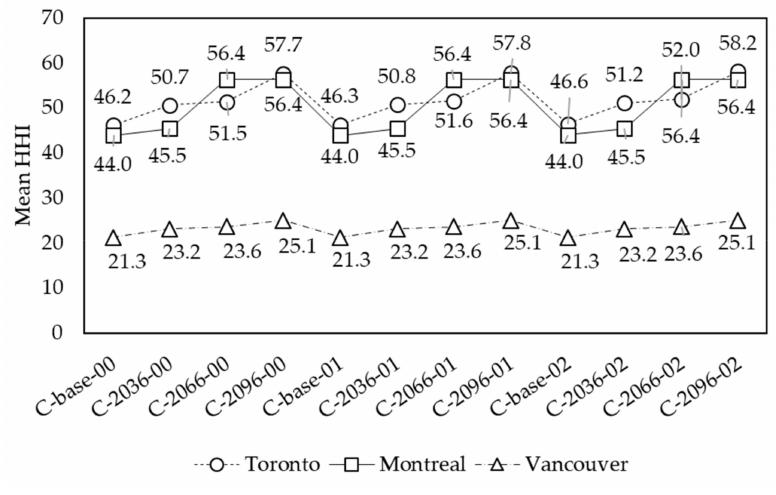
Comparing the trend of mean HHI of all twelve scenarios in Toronto, Montreal, and